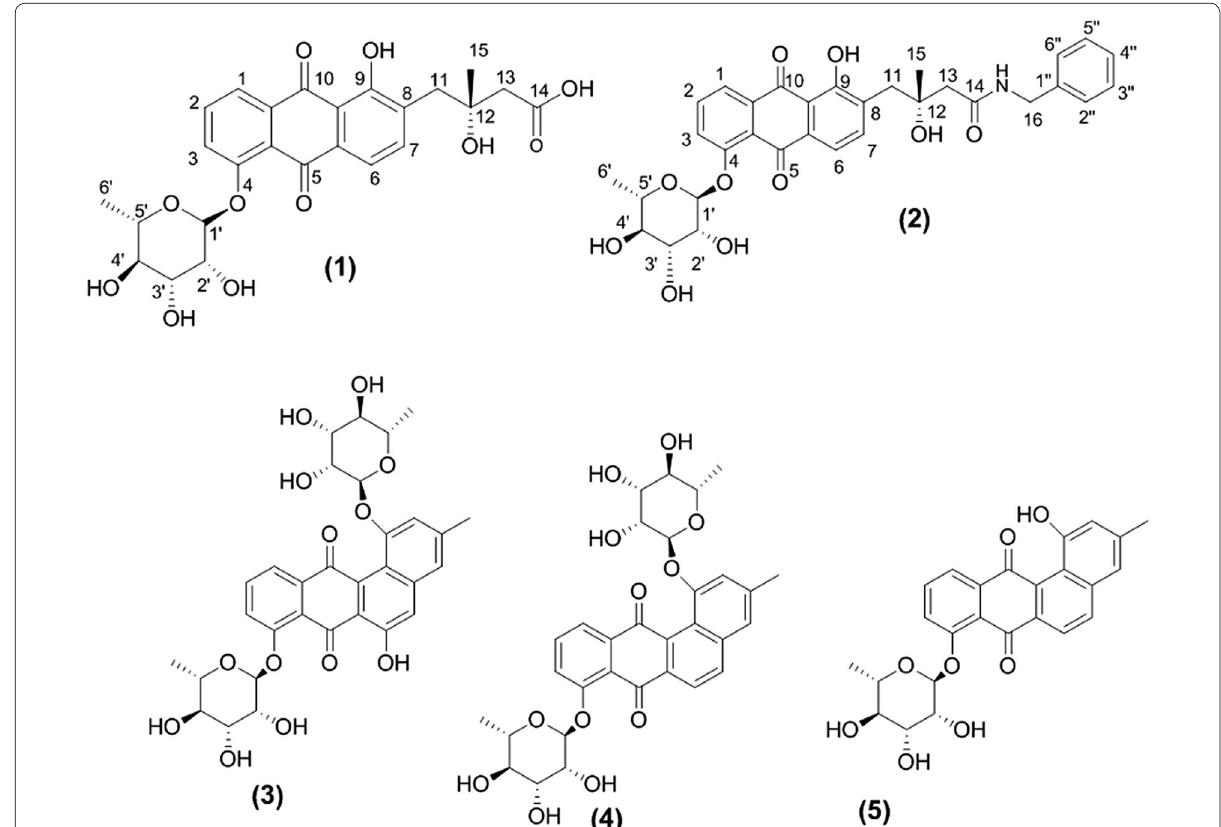
Fig. 3 Structures of the isolated compounds: fridamycin H ( 1 ) and I ( 2 ), actinosprin C ( 3 ), D ( 4 ) and G ( 5